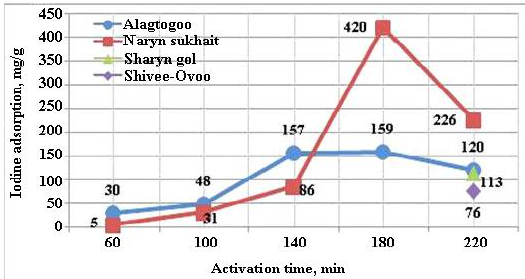
Figure 1. Comparison of iodine adsorption of active